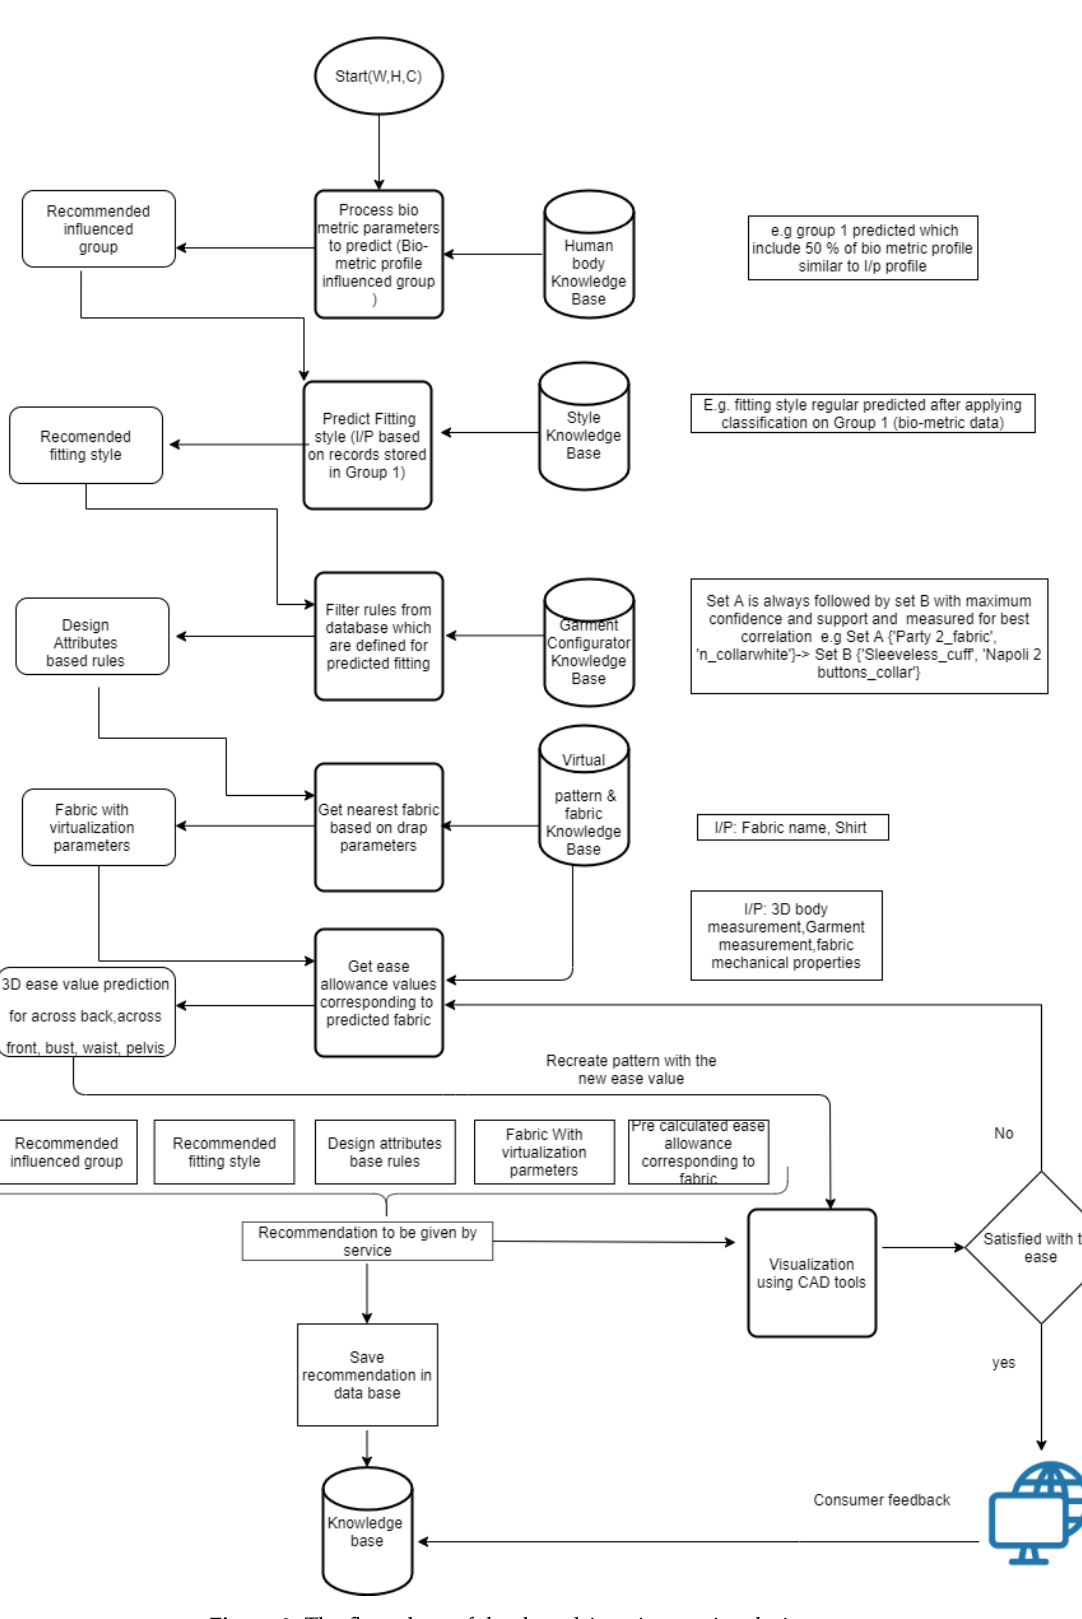
Figure 3. The flow chart of the data-driven interactive design